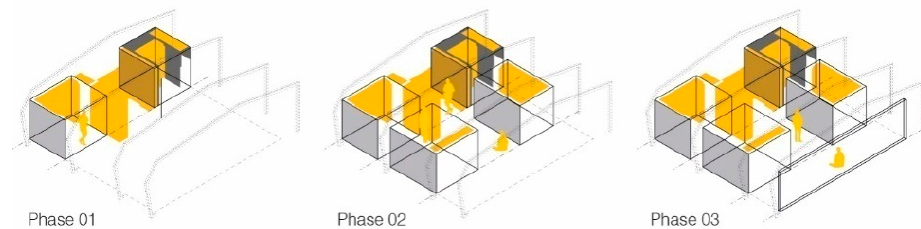
Figure 10. Diagram of housing space occupation phases.